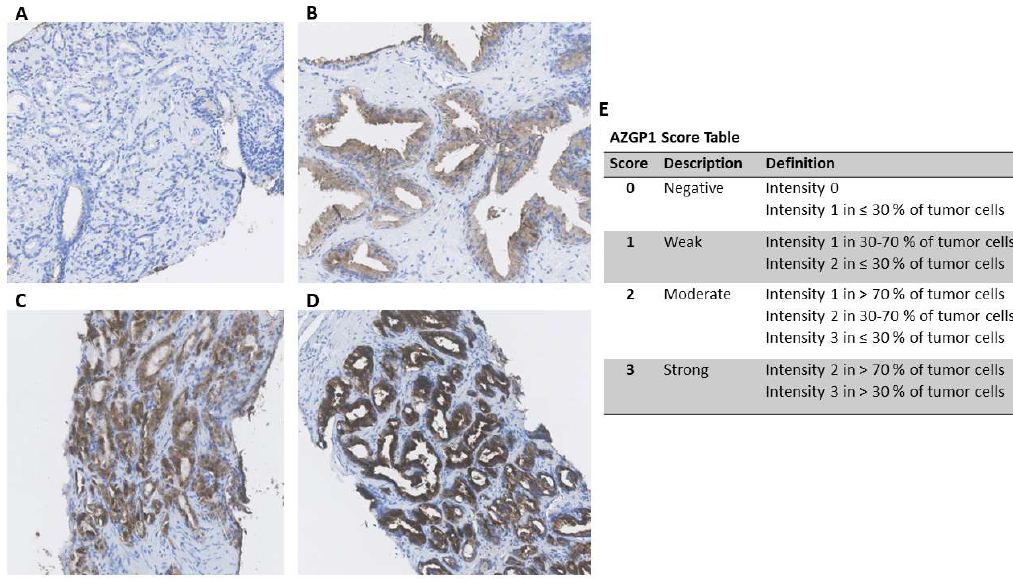
Figure 1. ( A – D ) Immunohistochemical Zinc-alpha 2 glycoprotein (AZGP1) staining in representative prostate cancer biopsies displaying negative ( A ), weak ( B ), moderate ( C ), and strong ( D ) staining. ( E ) AZGP1 score table.